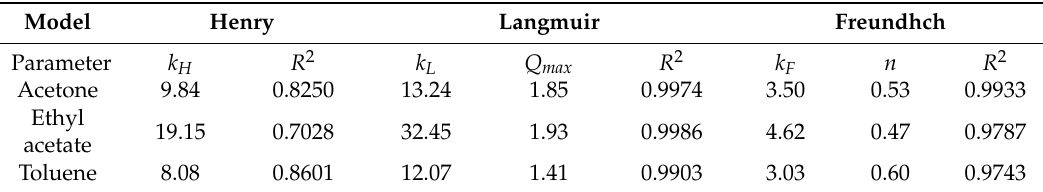
Table 6. Adsorption isotherm parameters of three probe VOCs. Q max (mol·g −1 ) = maximum adsorption